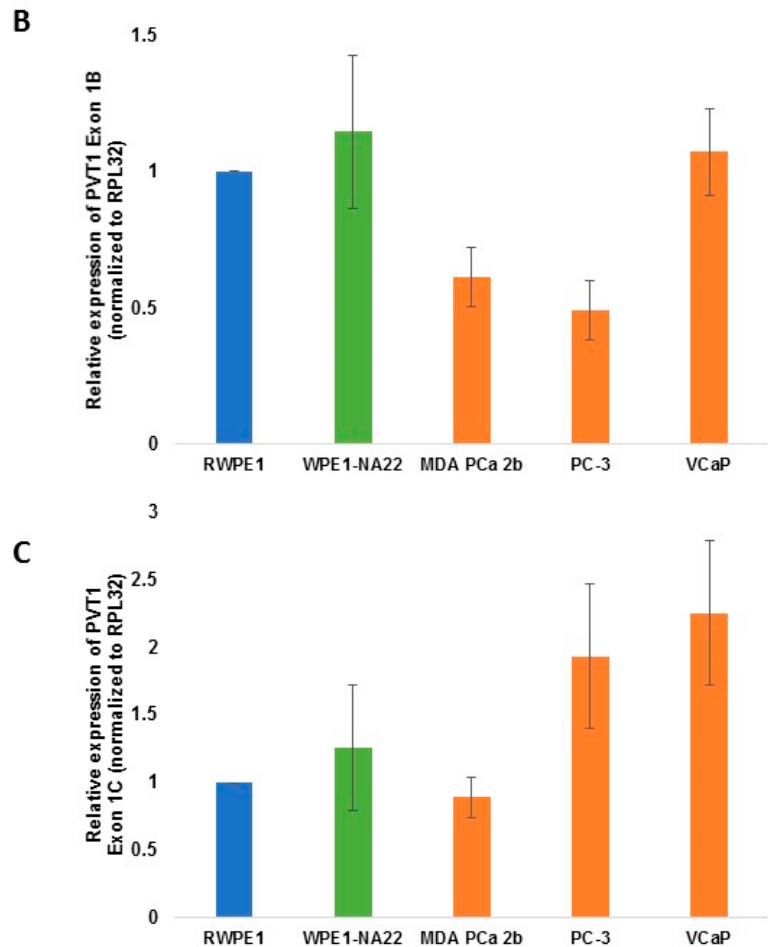
Figure 2. PVT1 exons 1a ( A ); 1b ( B ) and 1c ( C ) expression in non-tumorigenic and tumorigenic prostate epithelial cell lines. Four independent qPCR experiments were performed and every experiment was set up in quadruplicates. The data showed that there is no significant differential expression of the exons in the cell lines in comparing cell lines derived from CM with those derived from MoAA. The data are presented as mean + standard error of the mean (SEM).